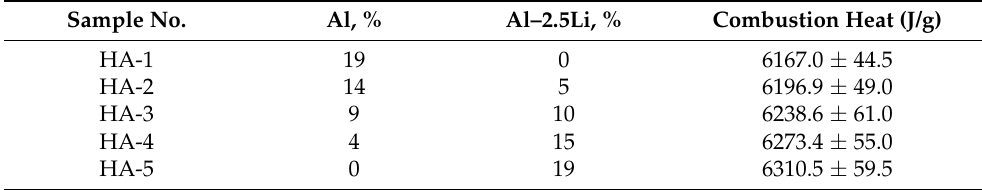
Table 2. Combustion heat of HTPB propellant containing Al–2.5Li alloy. Sample No.